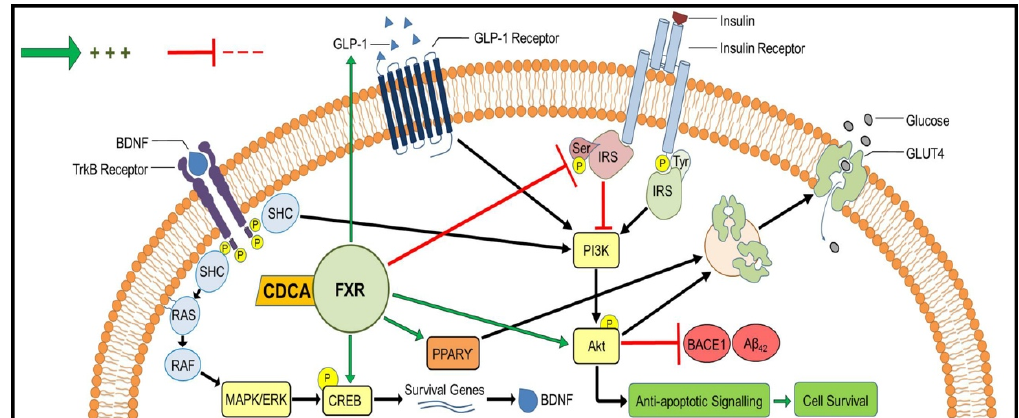
Figure 7. CDCA-mediated effects in ameliorating insulin resistance and AD pathologies. The vital role of CDCA in enhancing insulin signaling is mainly attributed to its ability to lower IRS1 serine phosphorylation, promote Akt activation and reduce Aβ production. CDCA also elevates hippocampal contents of GLP-1 and PPARγ that both take a part in insulin signaling. Moreover, CDCA enhances the activation of CREB to promote BDNF and neuronal survival. Akt: protein kinase